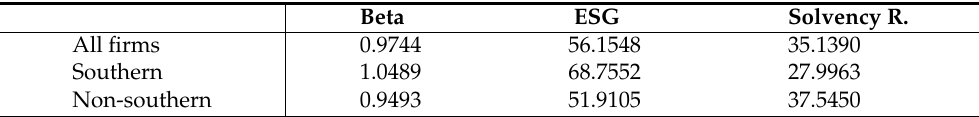
Figure 5. ESG ratings of the firms in our dataset. Source: authors’ calculations. ( a ) ESG ratings for all firms and years. ( b ) ESG ratings for all firms for each year. Table 2. Averages of the regressor variables by the location of the firms.